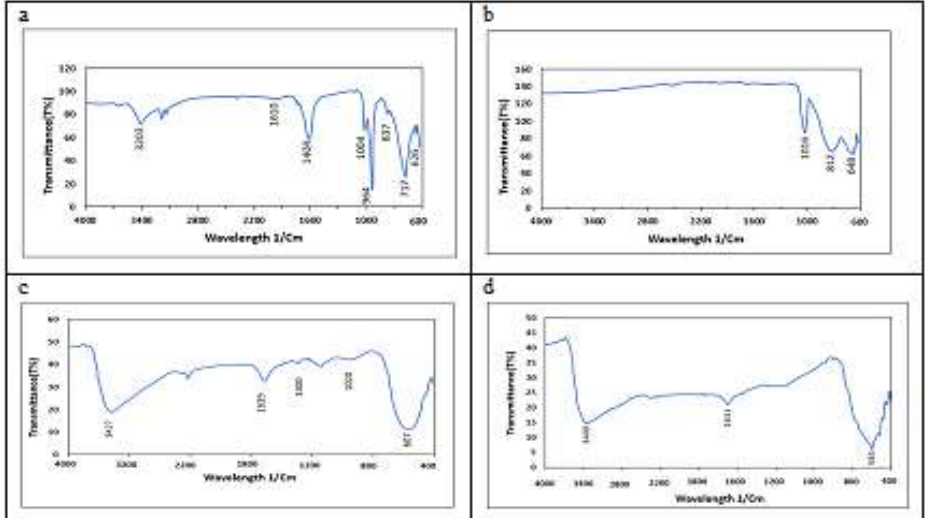
Figure (2): FTIR spectra of V 2 O 5 a: as- prepared, b: annealing at 500° C and SnO 2 c: as-prepared, d: annealing at 500 °